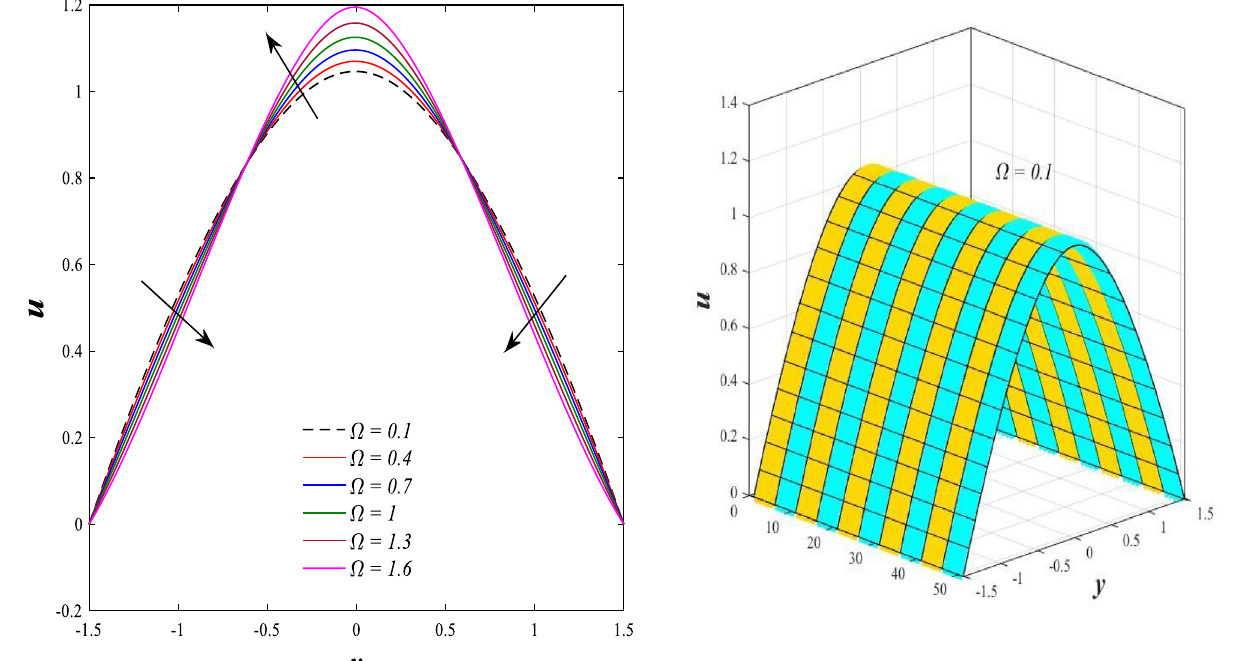
Figure 2. Effect of Rotation Ω on the axial velocity distribution 2D and 3D.